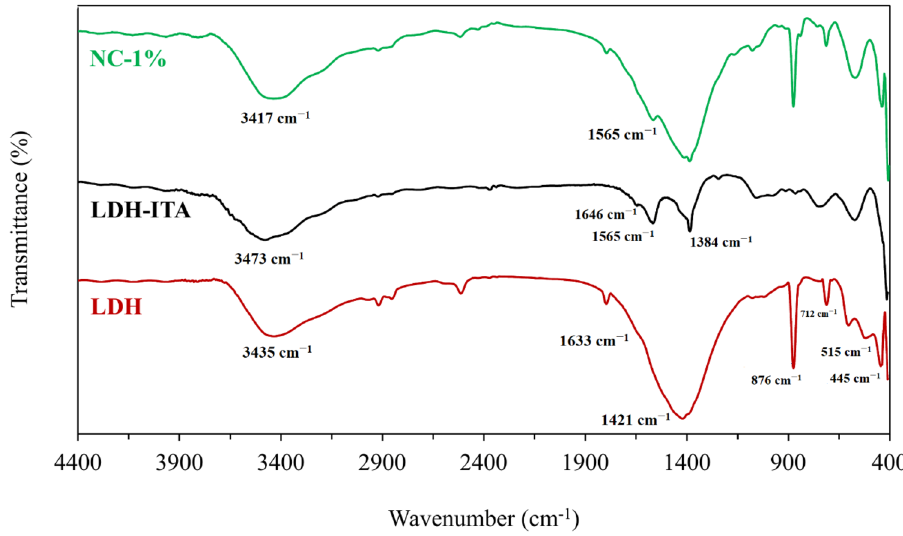
Figure 2. The FT-IR spectra of pristine LDH, LDH-ITA, and NC-1%.